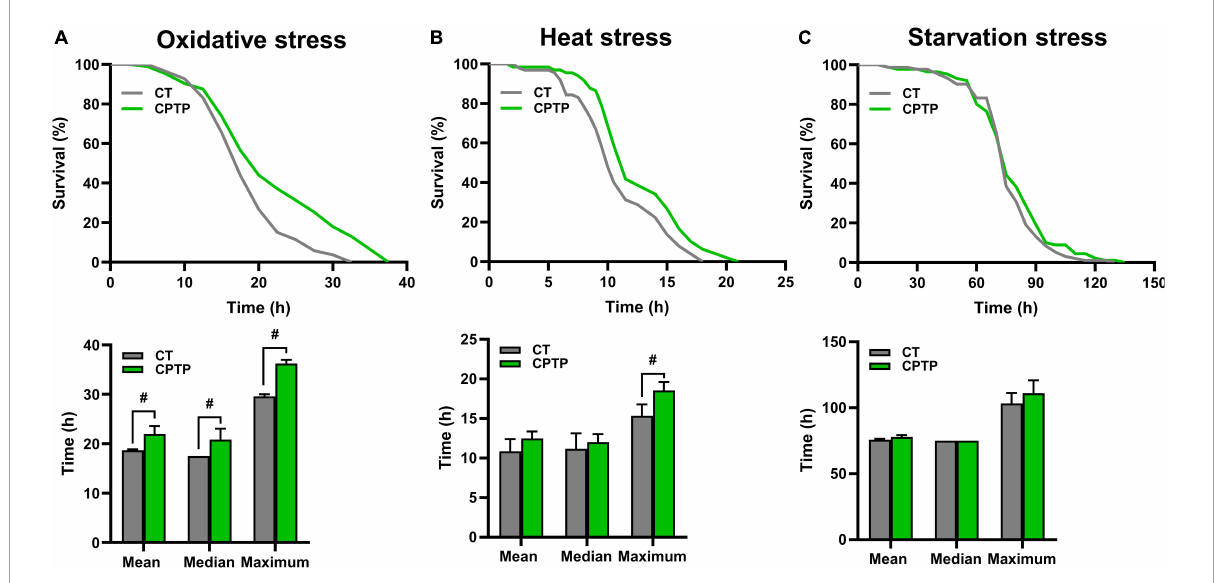
FIGURE3 Chinese pond turtle peptide (CPTP) improved stress resistance in female flies. (A) Oxidative stress; (B) Heat stress; and (C) Starvation stress. n = 180–210 flies per group. The data are presented as mean ± SEM. Statistical test: two-tailed unpaired t -test ( # P < 0.05 vs. CT group).